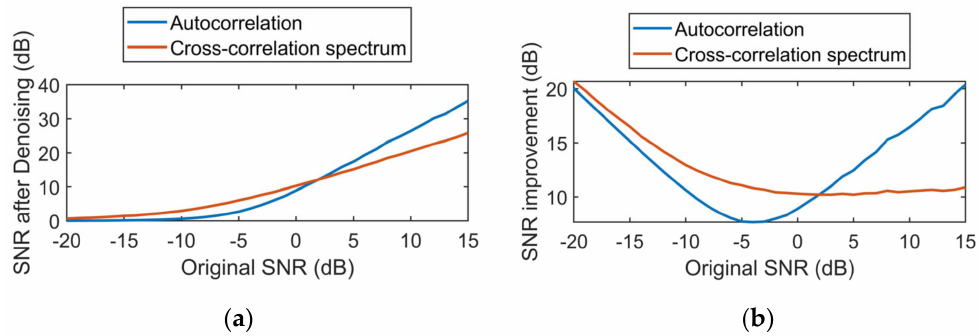
Figure 8. ( a ) SNR after using methods; ( b ) SNR improvements due to the